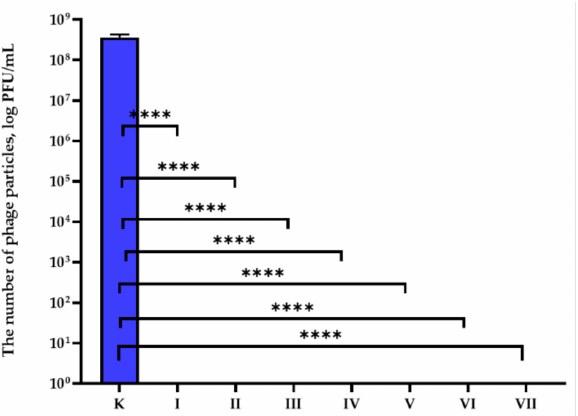
Figure 6. The influence of coated, active films on bacteriophage titer. One-way ANOVA: ****— p < 0.0001. Table 2. The influence of coated, active films on bacteriophage titer. The Number of phi6 Phage Particles (PFU/mL)